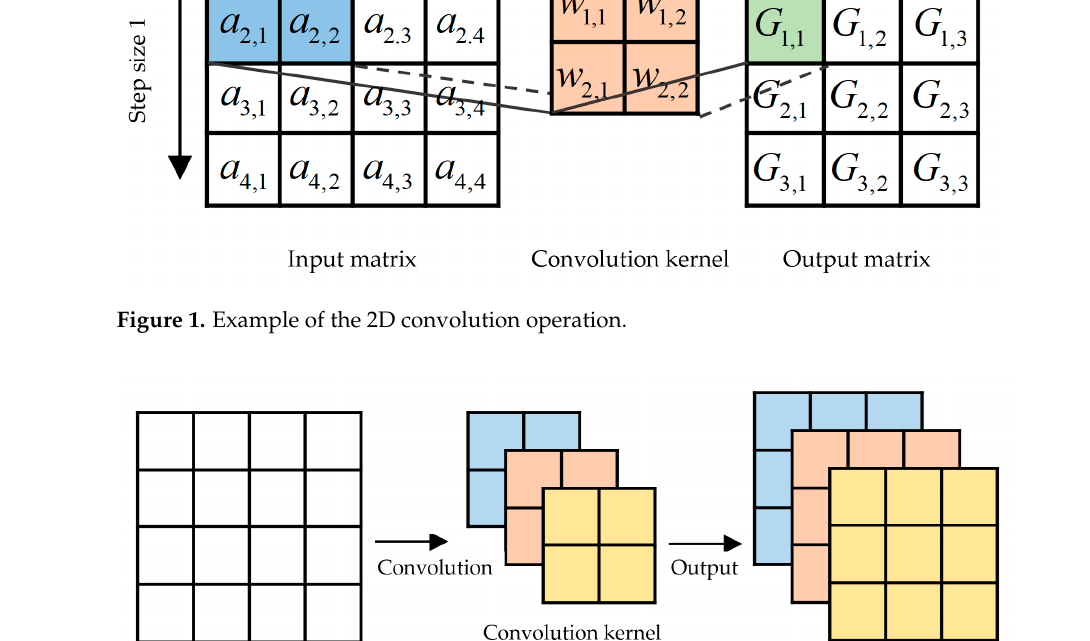
Figure 2. Example of the multi-channel convolution operation .